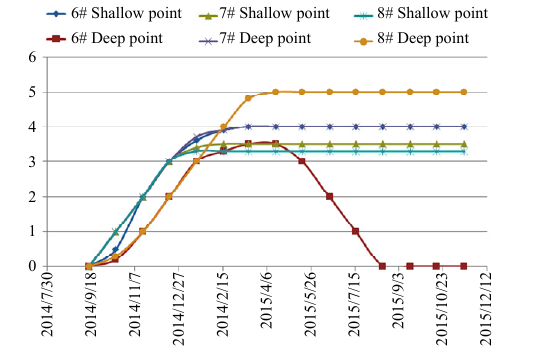
Fig. 8 Monitoring data of FBG-based displacement sensor.